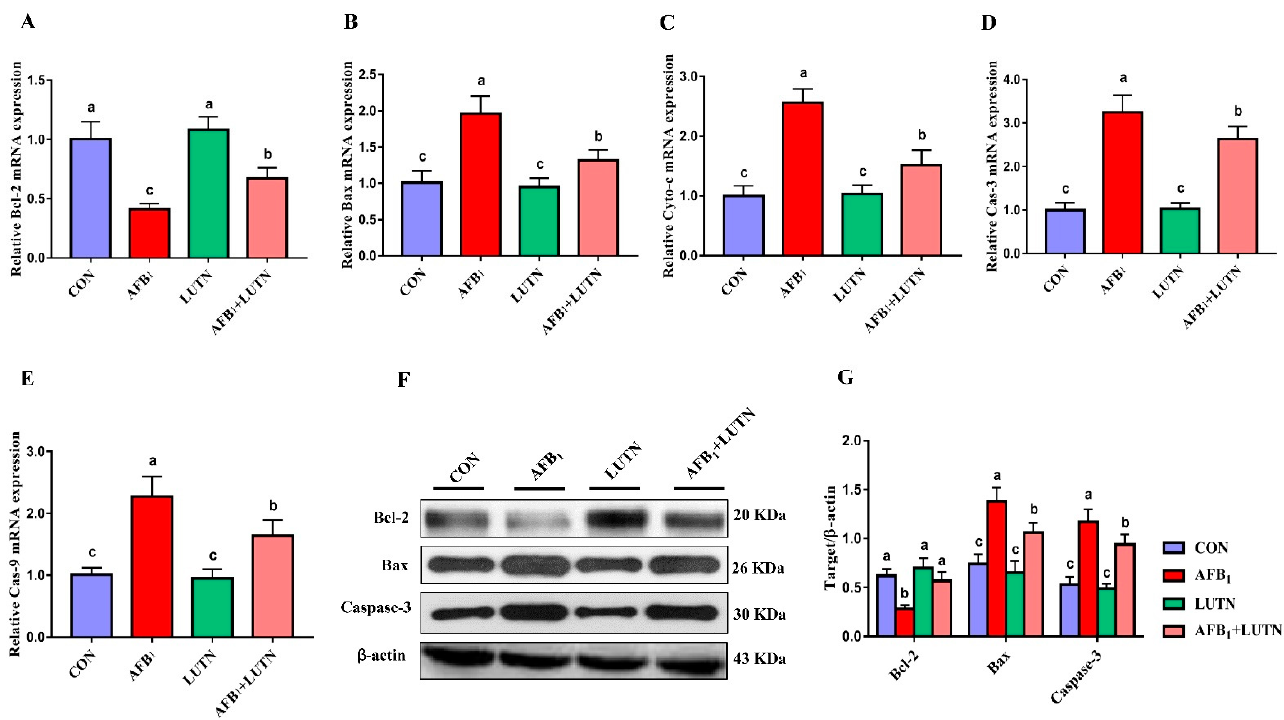
Figure 6. Luteolin treatment restrains AFB 1 -induced mitochondrial-mediated apoptosis pathway. The relative expression of mitochondrial-mediated apoptosis pathway transcripts was analyzed by qRT-PCR. ( A – E ) The relative mRNA expression of Bcl-2, Bax, Cyto-c, Cas-3 and Cas-9. The results are presented as mean ± SD ( n = 6). Western blotting was used to detect the expression of mitochondrial apoptosis-associated proteins. ( F ) Western blotting analysis of Bcl-2, Bax and Cas-3. ( G ) Quantitative analysis of western blotting for Bcl-2, Bax and Cas-3. The results are presented as mean ± SD ( n = 3). a–c Columns with different lowercase letters indicated significant differences between the compared groups ( p < 0.05). B-cell lymphoma 2 (Bcl-2); Bcl-2-associated X protein (Bax); cytochrome-c (Cyt-c); caspase-3 (Cas-3); caspase-9 (Cas-9).